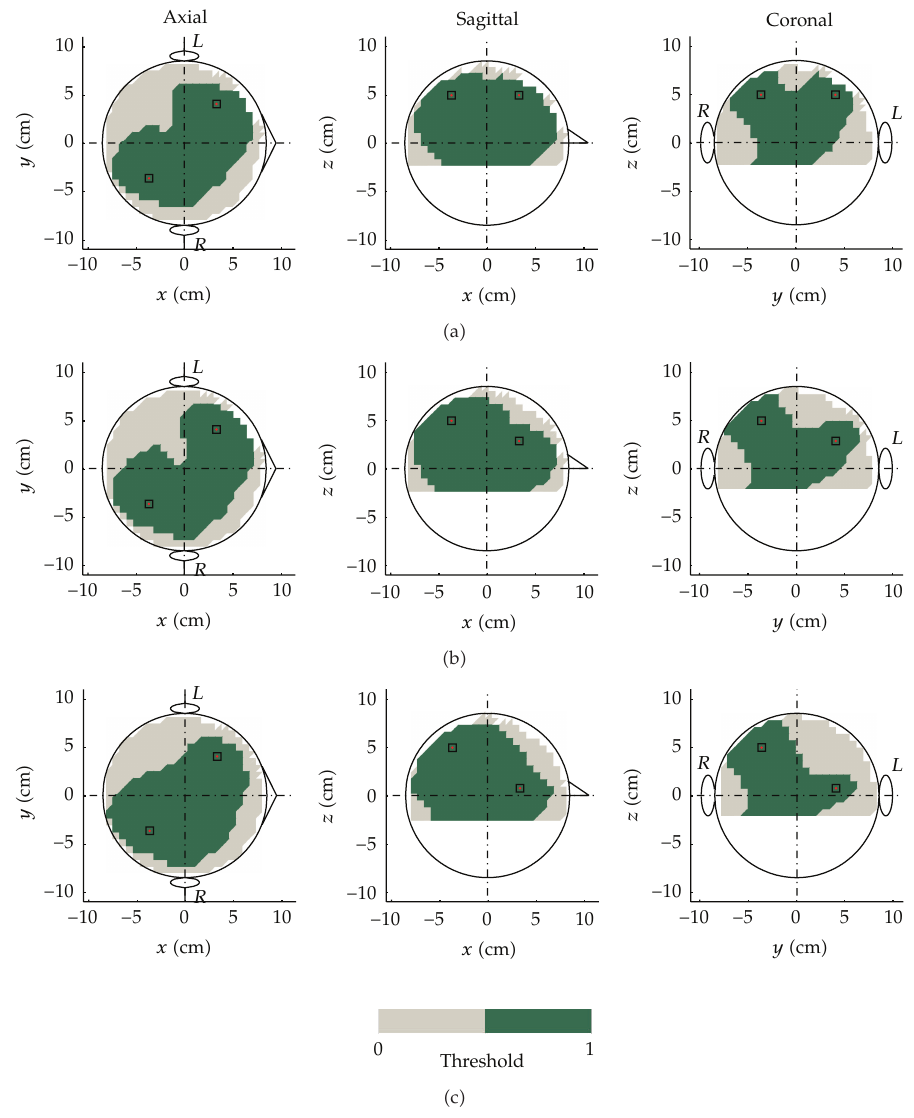
Figure 6: Reduced scanning regions by our proposed beamformer over varying source depths. Source configuration is the same as in Figure 1, except for the depth (cid:2) z -coordinate (cid:3) of one source. (cid:2) a (cid:3) Depth: z (cid:8) 5 . 0cm. (cid:2) b (cid:3) Depth: z (cid:8) 2 . 9cm. (cid:2) c (cid:3) Depth: z (cid:8) 0 .